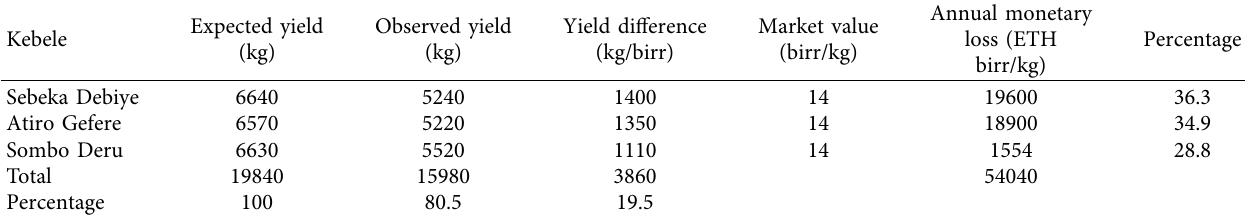
Table 8: Te amount of maize yield loss in terms of the market value caused by the olive baboon.